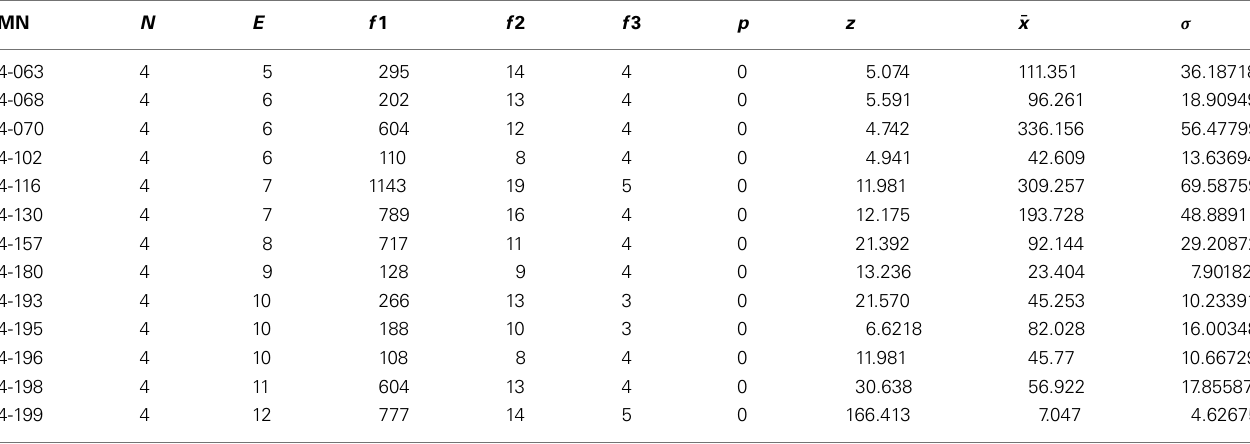
Table 4 | 13 Significant 4-node motifs from a total of 199 4-node motifs and 1000 rewiring randomizations of 49 regions and 464